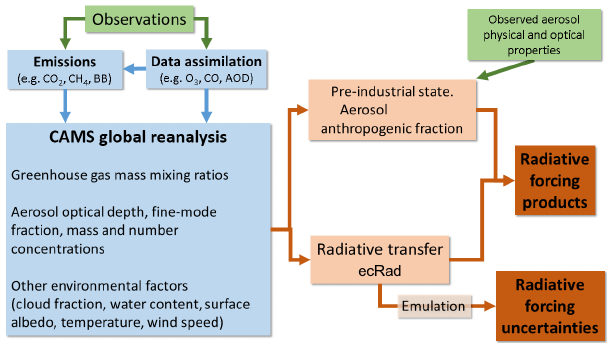
Figure 1. Diagram of the radiative-forcing production chain (light orange), which takes inputs from the CAMS global reanalysis (blue) and produces radiative-forcing estimates and their uncertainties (dark orange). Green boxes indicate observational constraints. BB stands for biomass burning, and AOD stands for aerosol optical depth. ecRad is the radiative-transfer code used by the ECMWF